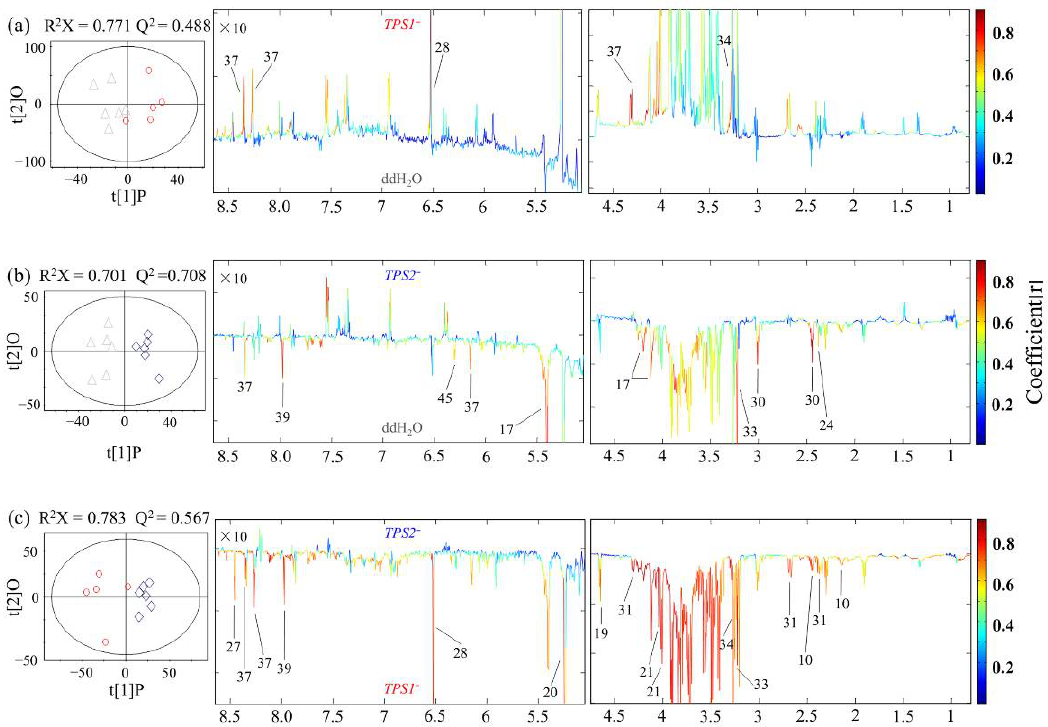
Figure 4. OPLS-DA scores plots ( left ) and coefficient-coded loadings plots ( right ) showing metabolic differences of FHB-susceptible wheat Annong 8455 inoculated with ( a ) TPS1 − (red) vs. ddH 2 O (grey) (CV-ANOVA p = 0.005), ( b ) TPS2 − (blue) vs. ddH 2 O (grey) (CV-ANOVA p = 0.001) and ( c ) TPS2 − (blue) vs. TPS1 − (red) (CV-ANOVA p = 0.005). Metabolite keys are the same as in Figure 1 and